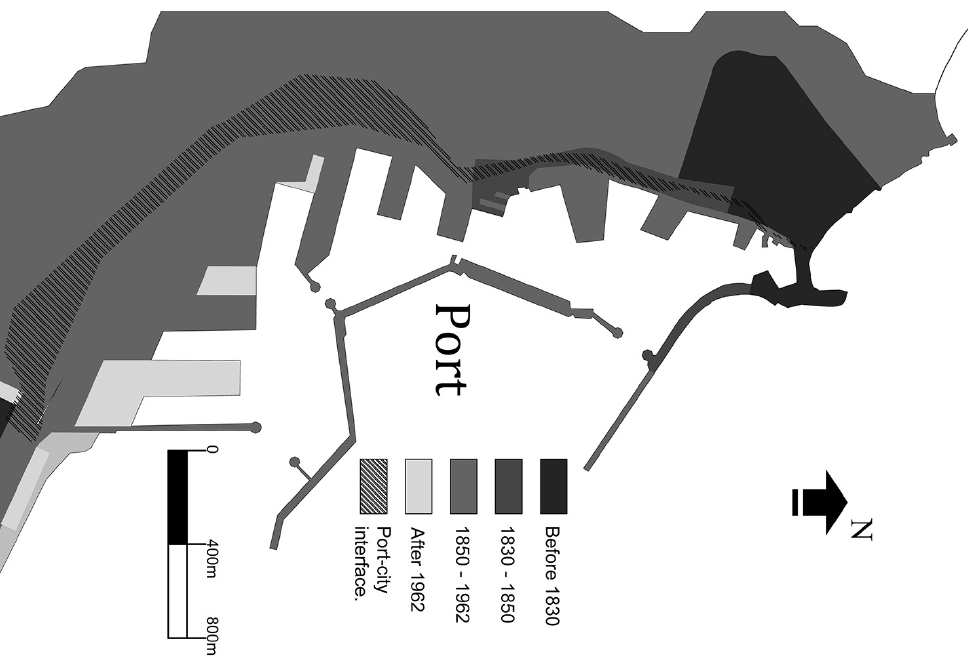
Figure 7. Diagram of Algiers’ current port‐city interface, divided according to its morphological evolution. Source: Produced by the authors, based on Google Earth with the distinctions of the different periods visualised in accordance with Hammache et al. (2000).